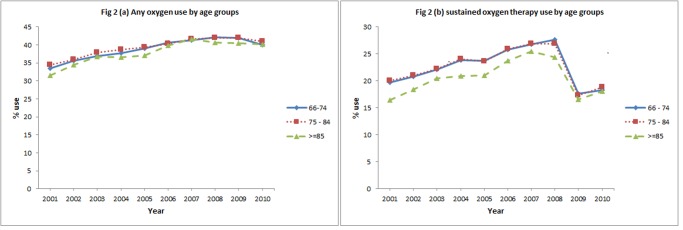
Any oxygen use by age groups, (a), and sustained oxygen therapy use by age group, (b).